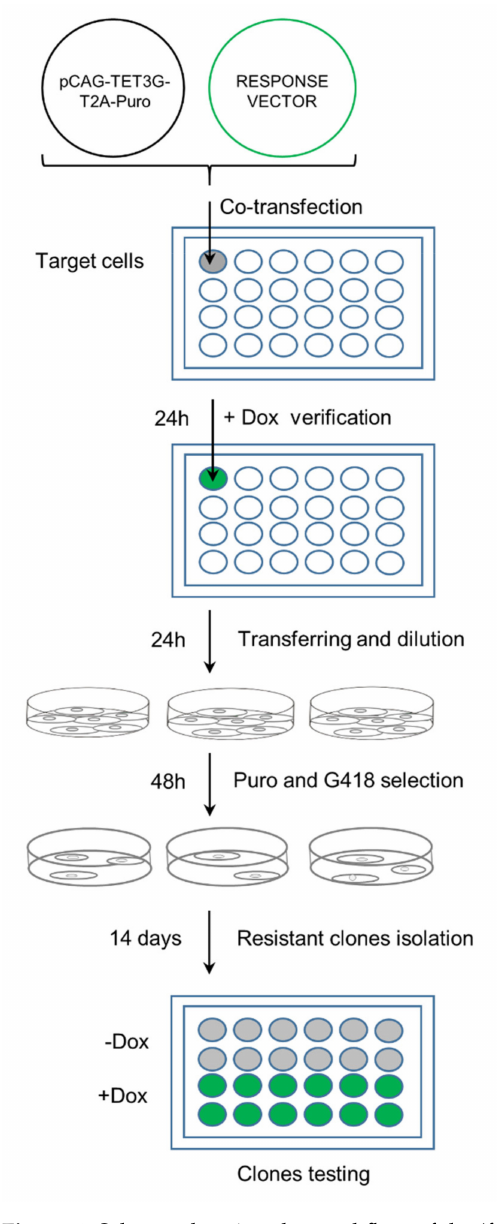
Figure 4. Scheme showing the workflow of the ‘fast-track’ protocol. Target cells were seeded on a 24-well plate and co-transfected with the regulatory and response plasmids in 1:1 ratio. After positive verification of the Dox-induced expression of GOI, cells from one well were transferred into three 10-cm dishes and, after the next 48 h, a combined selection with Puro and G418 was introduced. Resistant clones were isolated with cloning cylinders after 21 days, cultured, and tested for Dox inducibility in a 24-well plate